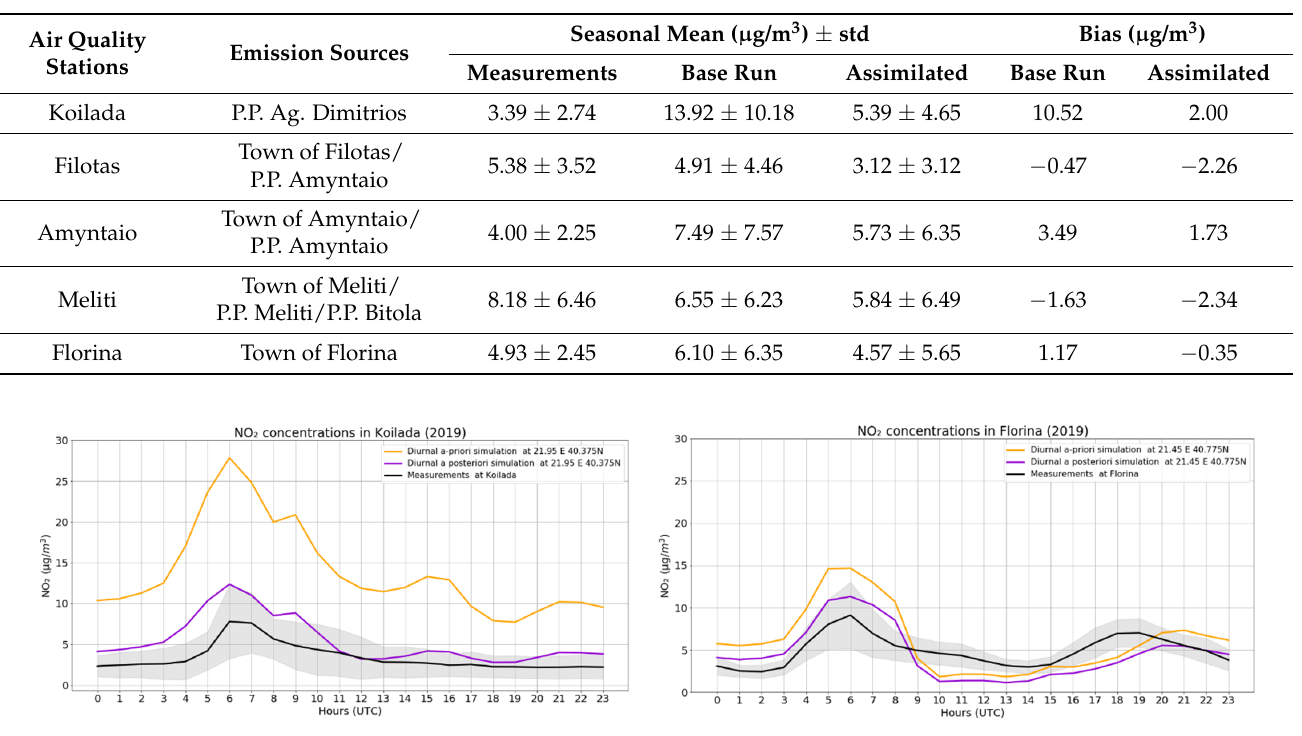
Table 4. Statistics of the comparison of LOTOS-EUROS surface simulations in the base and assimilated runs with surface measurements in the summer of 2019. P.P. refers to power plant.